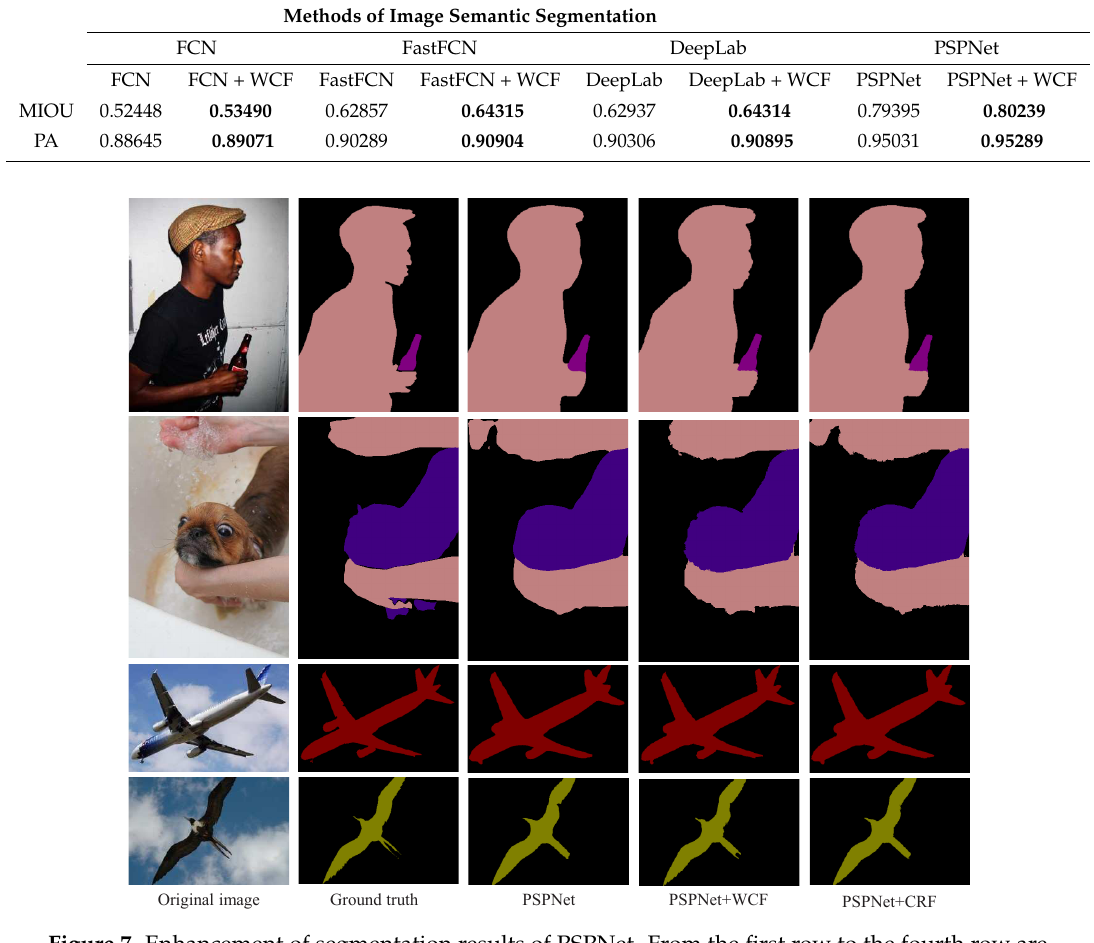
Figure 7. Enhancement of segmentation results of PSPNet. From the first row to the fourth row are man, dog, aircraft and bird, respectively. From the first column to the fifth column are the original images, the ground truth of images, the preliminary segmentation results by PSPNet, enhancement results by the proposed methods PSPNet+WCF and enhancement results by